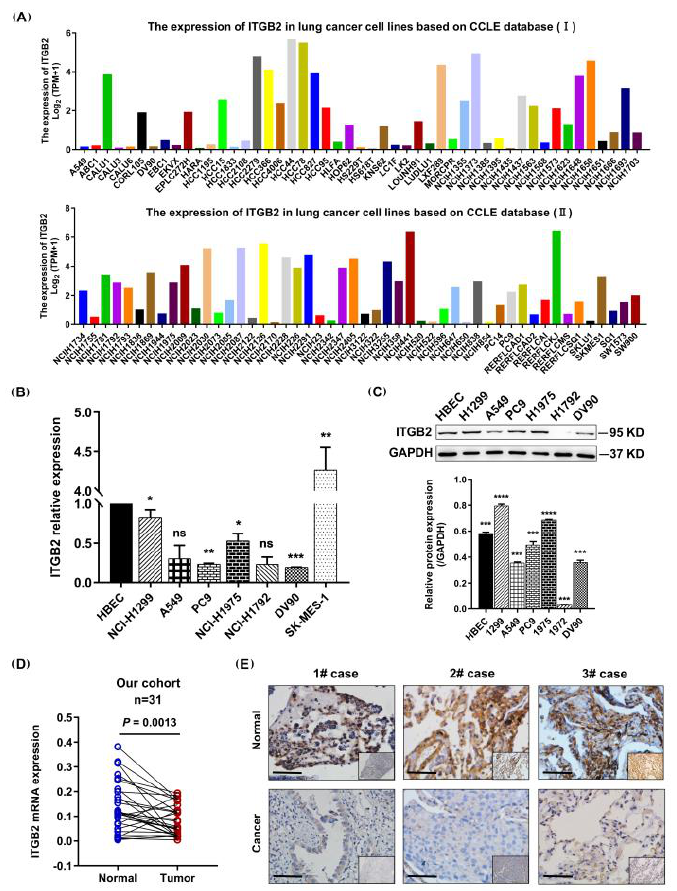
Figure 2. ITGB2 was commonly downregulated in the NSCLC cell lines and tissues. ( A ) Expression of ITGB2 in NSCLC cell lines in CCLE database. ( B , C ) ITGB2 expression at mRNA level ( B ) and protein level ( C ) in NSCLC cell lines. ( D ) The pairing difference analysis of ITGB2 expression between tumor and normal tissues ( n = 31). ( E ) Immunohistochemical staining of ITGB2 in tumor and non-tumor tissues from patients with NSCLC. Scale bars are shown in the figure (scale bars, 20 µ m). * P < 0.05, ** P < 0.01, *** P < 0.001, **** P < 0.0001.